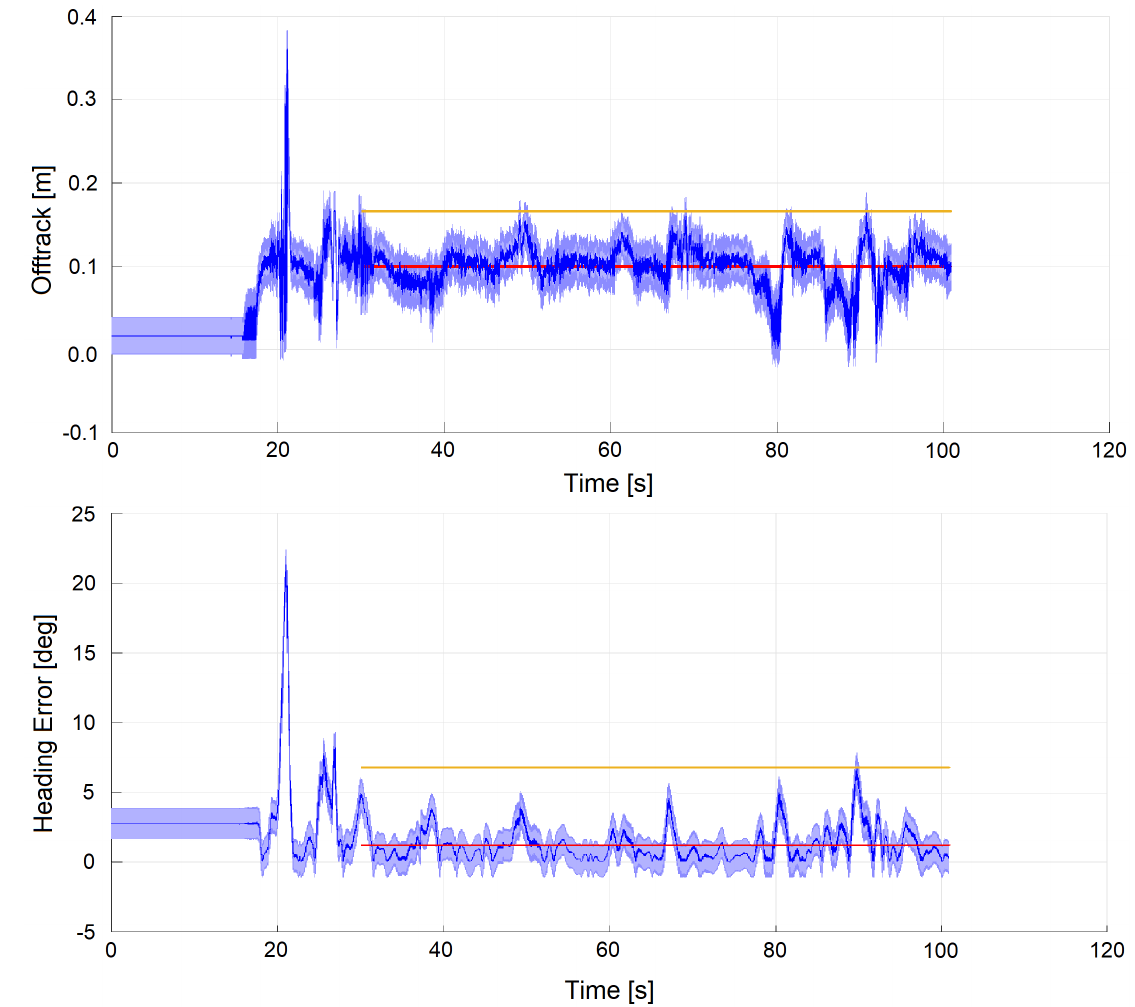
Figure 14. Autonomous lap at v max = 60 km/h. Signals are plotted together with standard deviation (light blue), mean (red) and maximum error (yellow). The measurement of such metrics starts when the car actually starts driving after